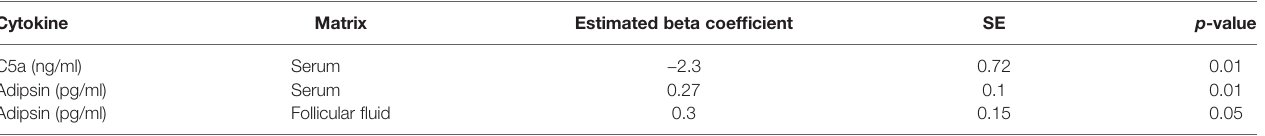
TABLE 2 | Complement factors exhibiting signi fi cant differences in sera prior to the IVF cycle and follicular fl uid of women with successful compared to unsuccessful pregnancies.